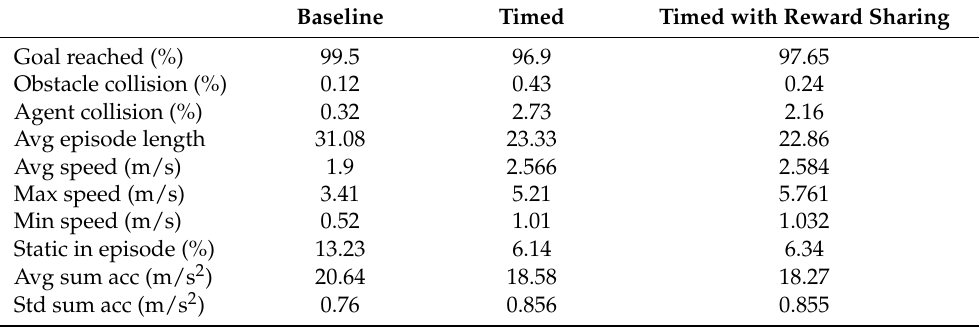
Static in episode (%) Std sum acc (m/s 2